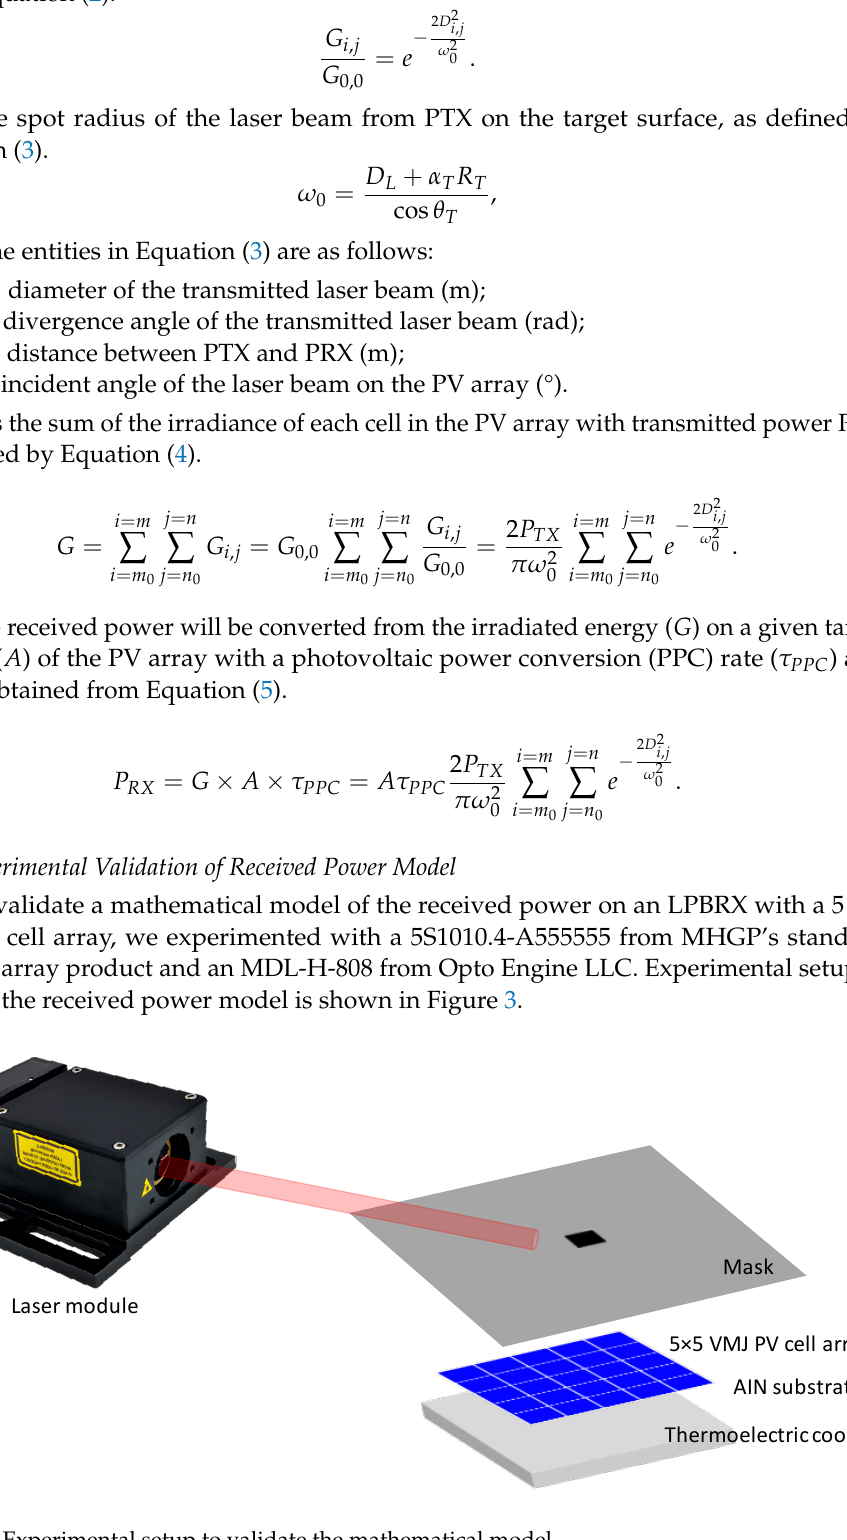
Figure 3. Experimental setup to validate the mathematical